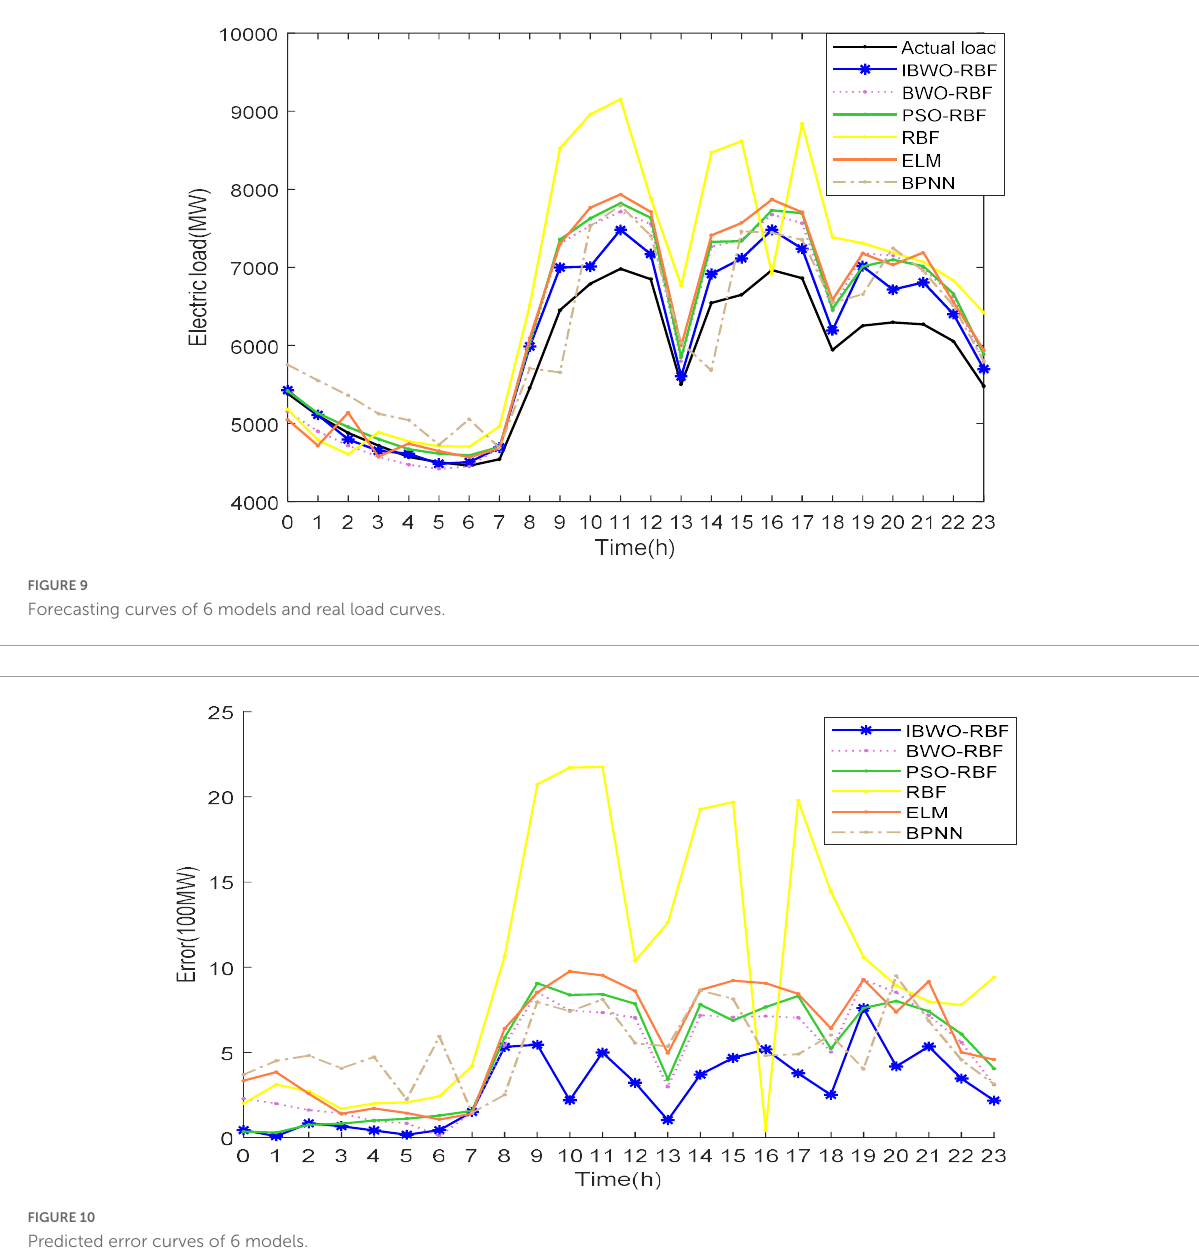
FIGURE10 Predicted error curves of 6